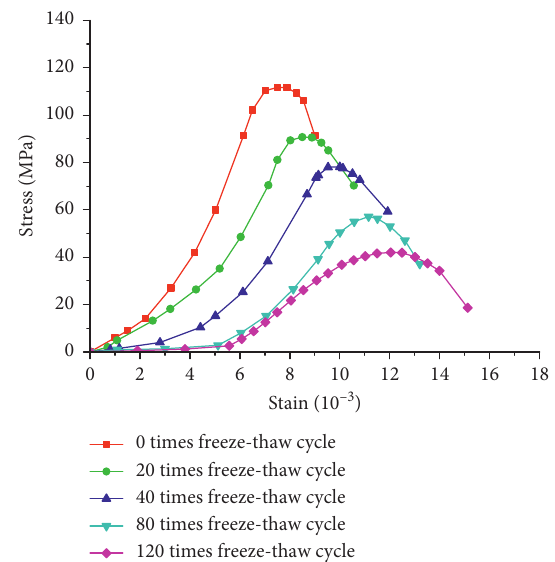
Figure 5: Stress-strain curves of sandstone in different freeze-thaw cycles under 0.055MPa impact pressure.